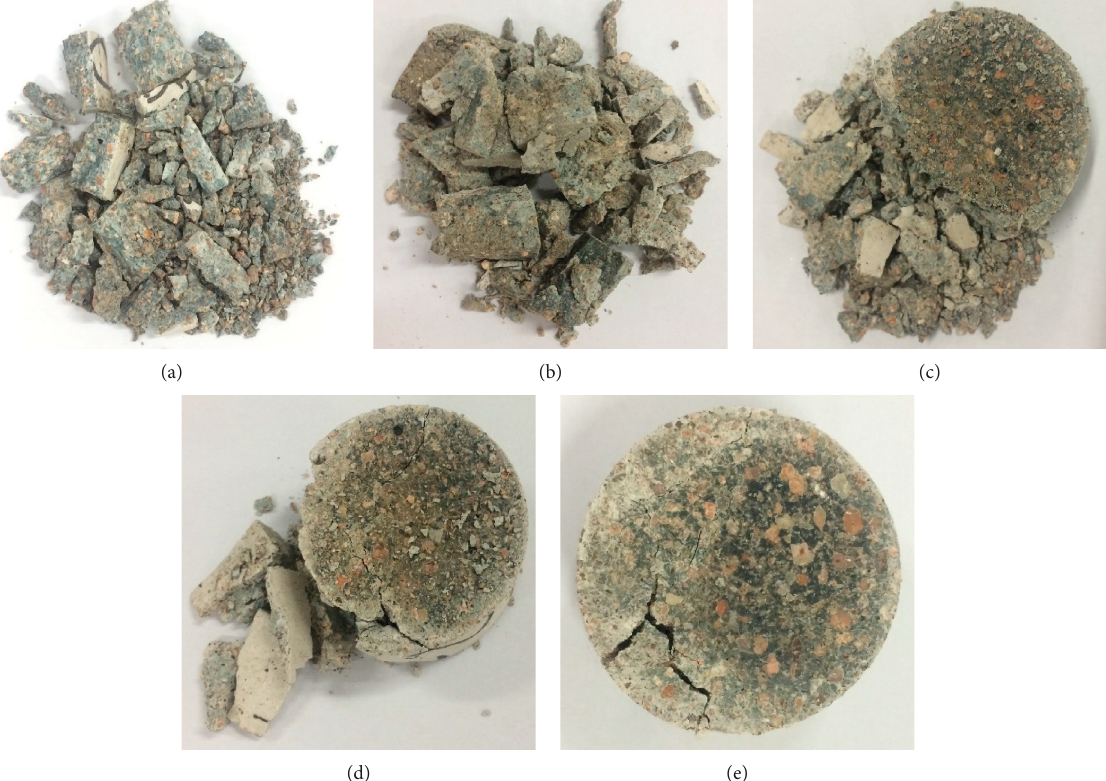
Figure 9: Effect of PPF content on failure morphology of AAS mortar specimens. (a) Control, (b) P1, (c) P2, (d) P3, and (e)